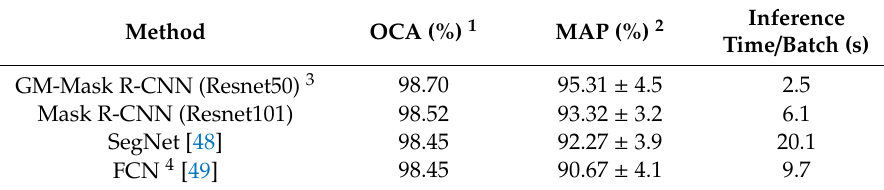
Table 6. Comparison of detection results for di ff erent